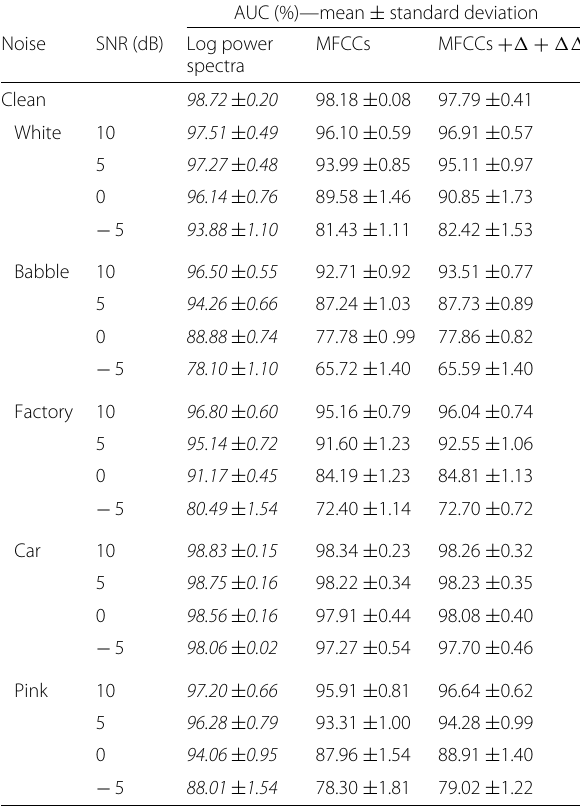
Table 4 AUC (%) comparison between DNN-based VAD methods using log power spectra and